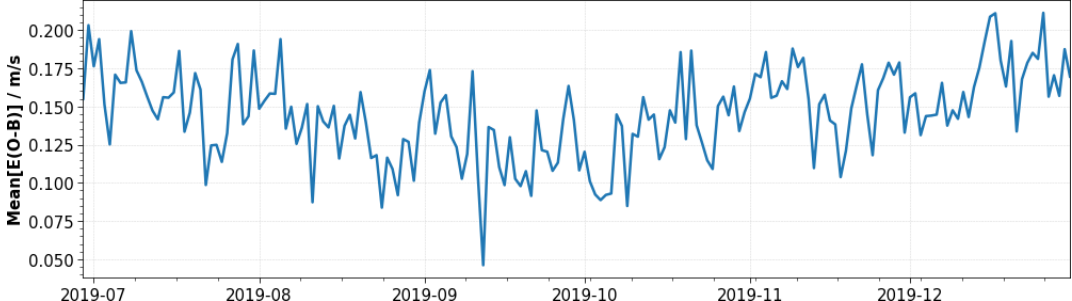
Figure 4. Time series of global (at all available radiosonde and pilot locations) 24h averages of E(O − B) values of ECMWF’s u -component winds computed for radiosondes and pilots (radiosondes that only measure wind) at all model levels.